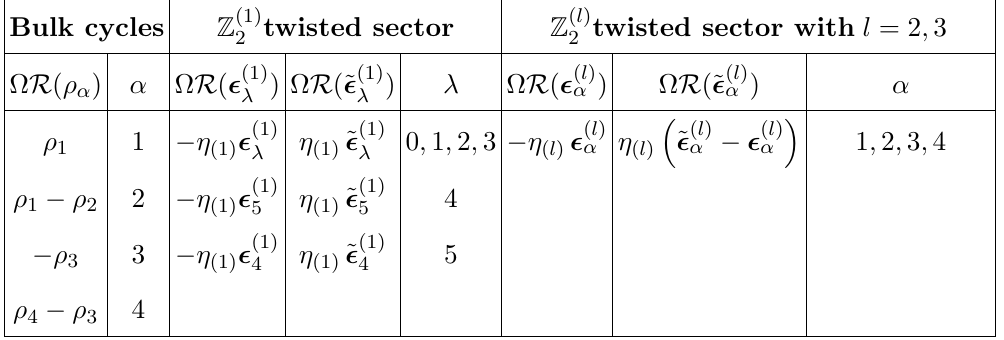
exceptional three-cycles for the 2